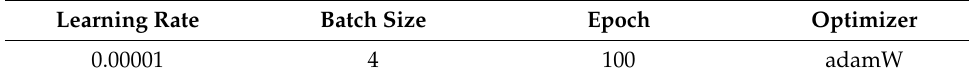
Table 2. Swin-T network hyper-parameter